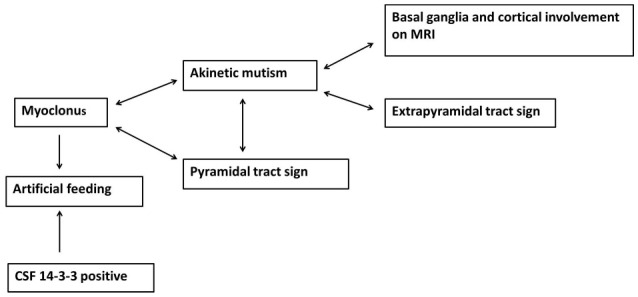
The association between neurological signs and brain MRI findings as well as myoclonus and detectable 14-3-3 protein in CSF leading to early artificial feeding in sporadic Creutzfeldt-Jakob disease.